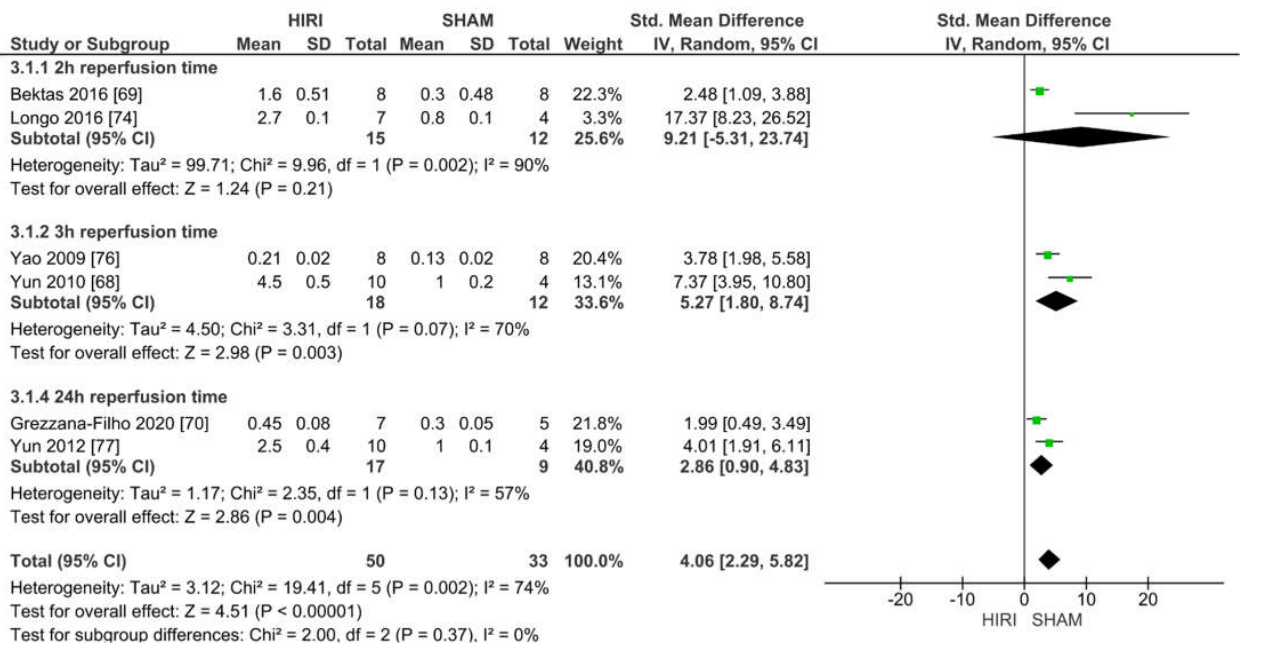
Figure 9. Forest plot of 70% HIRI in rats and 90 min warm ischaemia time grouped by reperfusion time between 2 and 24 h.